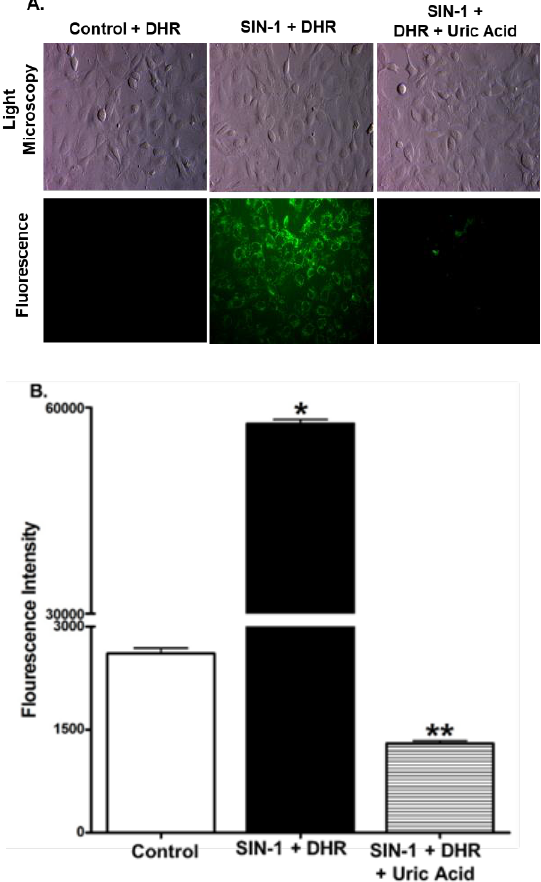
Figure 5. Dihydrorhodamine 123 oxidation by SIN-1 treatment in IEC-18 cells. ( A ) Dihydrorhodamine was oxidized by peroxynitrite produced from SIN-1 and therefore flourescence was observed in IEC-18 cells. ( B ) Intensity of the fluorescence produced due to oxidization of Dihydrorhodamine was significantly elevated in SIN-1 treated cells since uric acid prevents the oxidation there was no fluorescence measured in that condition. n = 4; * p < 0.001 (control Vs SIN-1), ** p < 0.01 (SIN-1 vs. SIN-1 + Uric acid).